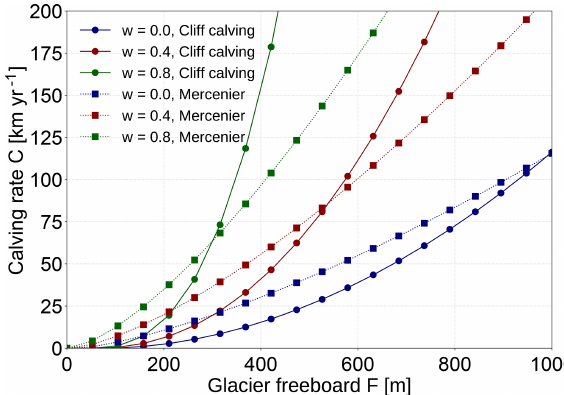
Figure 10. Comparison of the cliff-calving law given by Eq. (23) (continuous line) with the calving law for tidewater glaciers given by Mercenier et al. (2018), Eq. (22) (dotted line). Note that the cliff- calving rate could be scaled differently due to the uncertainty in C 0